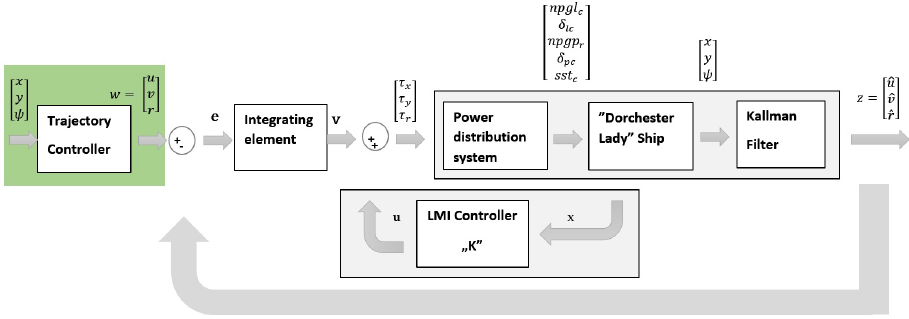
Figure 4. Block diagram system autonomous with trajectory controller (green area) and velocities controller (gray area).